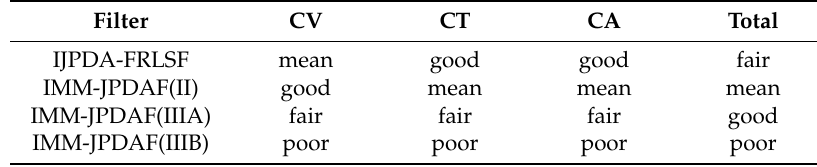
Table 4. The total performance evaluation for each filter.